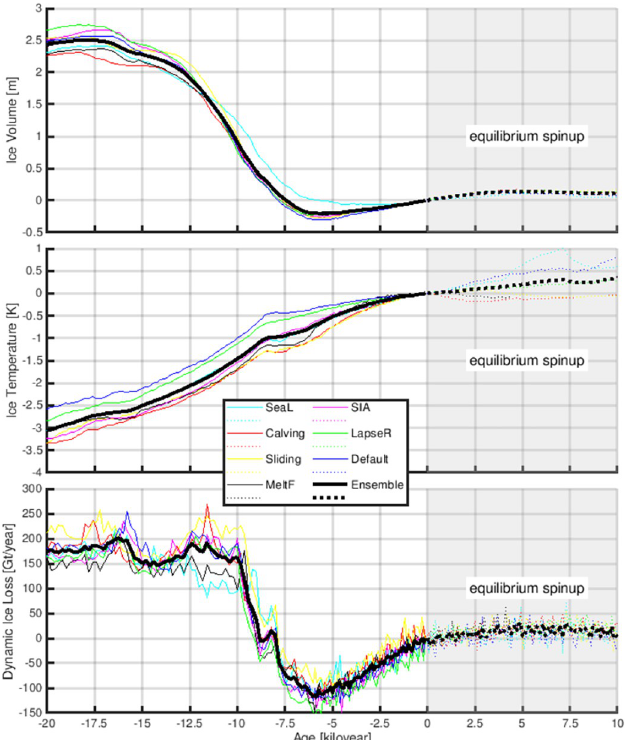
Fig 7. The simulated evolution of the (A, top) ice volume, (B, center) ice temperature (average over entire GrIS) and (C, bottom) dynamic ice loss in the paleo-spinup (solid lines) and the equilibrium-spinup (dashed lines). All results are given as anomalies with respect to the corresponding Pre-Industrial (i.e., 1850) values. The coloured lines are results from individual ensemble members, and the thick black lines are the ensemble mean.